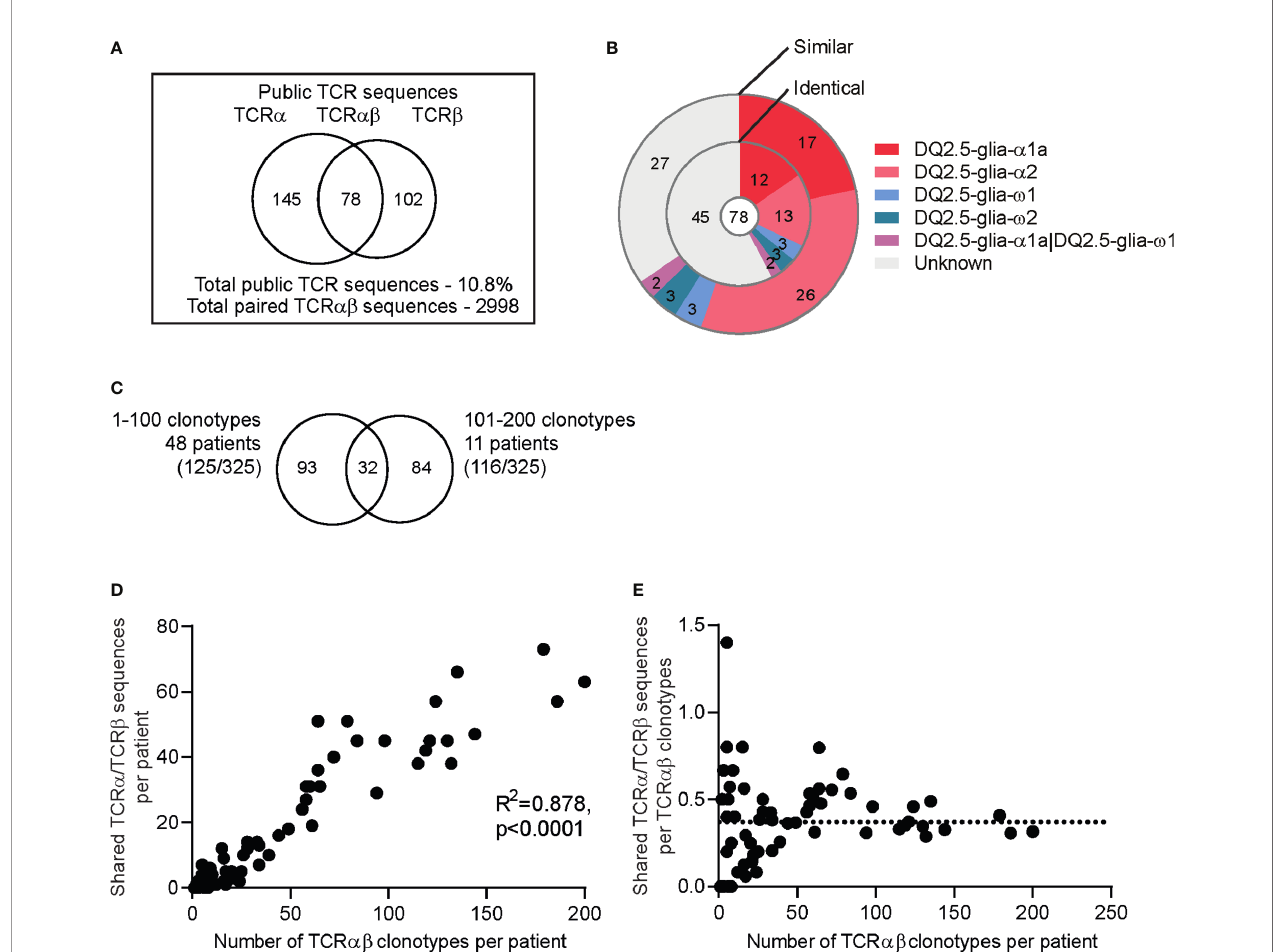
FIGURE 3 | Public TCR sequences among gluten-speci fi c T cells. (A) The number of public TCRs de fi ned as identical TCR a , TCR b or paired TCR ab amino acid sequences observed at least in two individuals in a dataset of total 2996 gluten-speci fi c TCR ab sequences from 63 patients. (B) Doughnut chart showing the epitope speci fi city of the 78 public paired TCR ab sequences. The inner circle displays the paired TCR ab sequences that are identical to the TCR ab sequences of TCRs with known epitope speci fi city while the outer circle displays the paired TCR ab sequences that have similar (1 amino acid difference) TCR b or TCR ab sequences. (C) Plot showing the number of shared TCR a /TCR b sequences and the number of TCR ab clonotypes in each patient. (D) Intra-comparison of the shared TCR a /TCR b sequences between patients with 1 to 100 TCR ab clonotypes (n=47) and 101-200 TCR ab clonotypes (n=11). Total number of shared sequences within the groups are shown in parentheses. (E) The number of shared TCR a /TCR b sequences per TCR ab clonotypes in each patient. The stippled line indicates the median